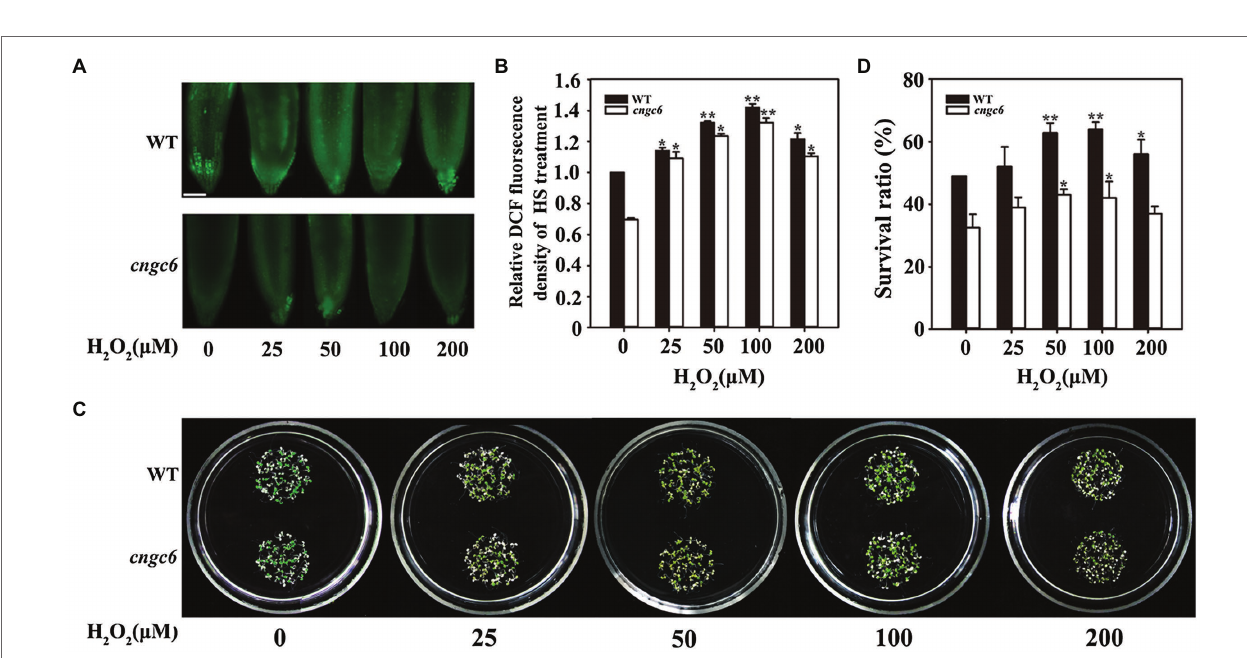
FIGURE 1 | Effects of calcium ions (Ca 2+ ) on hydrogen peroxide (H 2 O 2 ) accumulation in Arabidopsis seedlings. (A) About 8-day-old wild-type (WT), cngc6 , and COM12 seedlings grown at 22 ° C were exposed to 45 ° C (heat shock, HS) or maintained at 22 ° C (Control) for 30 min. The H 2 O 2 levels in the seedlings were then examined by fluorescence microscopy using roots dyed with 5-(and-6)-chloromethyl-29,79-dichlorodihydrofluorescein diacetate (CM-H 2 DCFDA). Bar = 100 μ m. (B) Relative dichlorodihydrofluorescein (DCF) fluorescence densities in the roots. The data presented are the means ± SE of measurements taken from five independent experiments with at least 10 roots for each treatment. * p < 0.05 vs. Col (Student’s t -test). (C,E,G) About 8-day-old seedlings of wild-type (C) , cngc6 (E) , and COM2 (G) were exposed to 45 ° C (HS) or maintained at 22 ° C (Control) for 30 min. The H 2 O 2 levels in the plants were then examined by fluorescence microscopy using roots stained with CM-H 2 DCFDA. Bar = 100 μ m. (D,F,H) The relative DCF fluorescence densities in the roots of wild-type (D) , cngc6 (F) , and COM2 (H) . The data presented are the means ± SE of measurements taken from five independent experiments with at least 10 roots for each treatment. * p < 0.05 vs. 0 mM CaCl 2 (Student’s t -test).